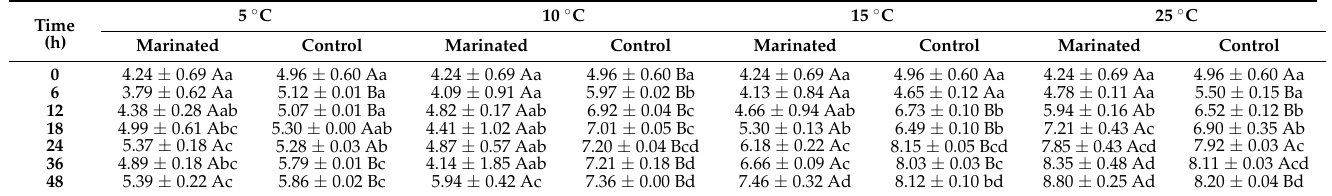
Table 3. Pseudomonas spp. count (log CFU/g) of cinnamon-marinated meat and control (non- marinated meat) stored at 5, 10, 15, and 25 ◦